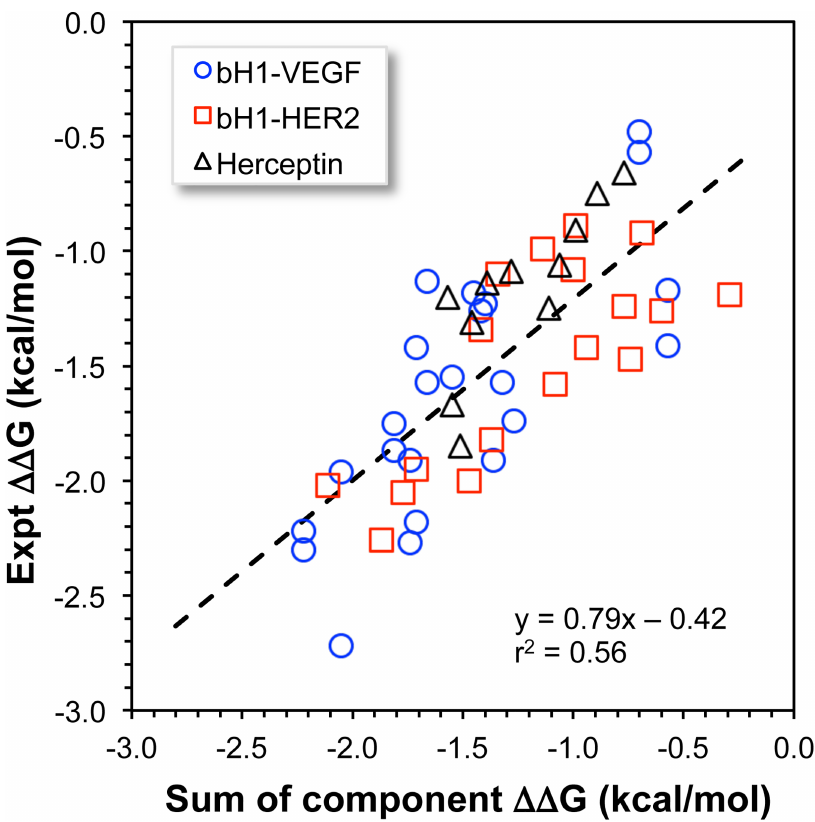
Fig 4. Additivity of contribution of mutationsto binding affinity. Shownis a scatterplotof the experimentally measured relativebindingaffinitiesof doubleandtriplemutants versusthesumof independentlymeasured relativebindingaffinitiesof the component single/doublemutants.The dashedlineis the linearregression linefor the entireset.